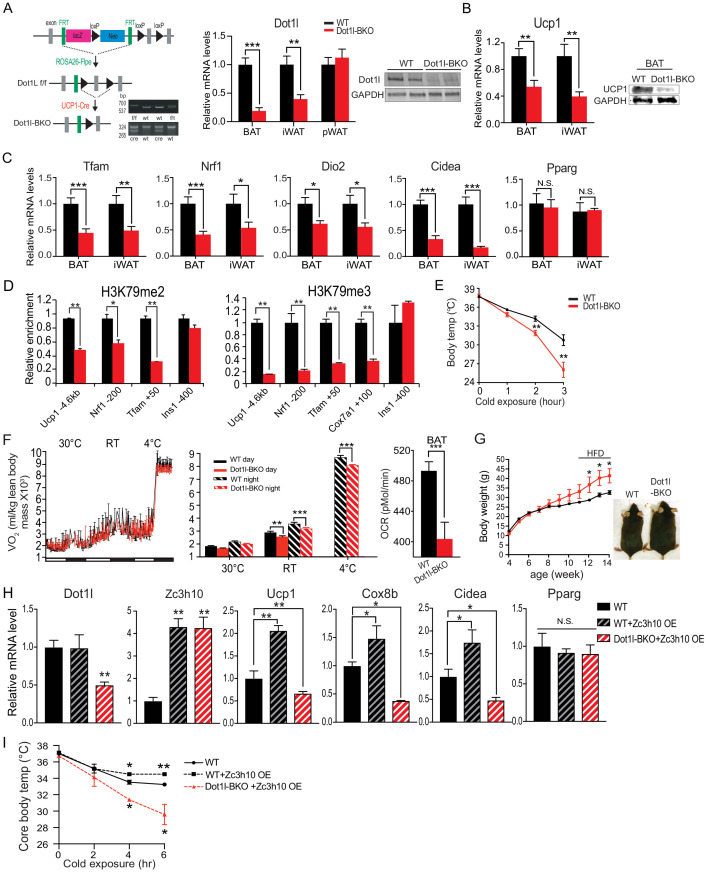
The requirement of Dot1l for cold-induced thermogenesis and the Dot1l-Zc3h10 function in mice.(A) (Left) Schematic diagram of the strategy used to generate BAT-specific Dot1l conditional knockout mice. PCR genotyping of the mice: Top gel, Dot1l allele; bottom gel, Cre. (Middle) RT-qPCR for Dot1l in BAT, iWAT and pWAT from Dot1l f/f (WT) and Dot1l-BKO mice (n = 6 per group). (Right) Immunoblotting for Dot1l in BAT from Dot1l f/f (WT) and Dot1l-BKO mice. (B) RT-qPCR and immunoblotting for Ucp1 in BAT and iWAT from Dot1l f/f (WT) and Dot1l-BKO mice. (C) RT-qPCR for indicated genes in BAT and iWAT from Dot1l f/f (WT) and Dot1l-BKO mice. (D) ChIP-qPCR of H3K79me2 and H3K79me3 at Zc3h10-binding regions of BAT tissue from control (f/f) or Dot1l-BKO mice (n = 5 per group). (E) Rectal temperature measured in 13-week-old mice at 4°C at indicated time points (hours) (n = 6 mice per group). (F) (Left) whole body VO2 assayed in WT and Dot1l-BKO mice, housed at indicated ambient temperatures (n = 6 per group) by indirect calorimetry using CLAMS. (Right) OCR measured in BAT of WT and Dot1l-BKO mice using Seahorse XF24 Analyzer (n = 5 per group). (G) Representative photograph of 14-week-old control and body weight of WT and Dot1l-BKO mice fed HFD from wk 12. (H) RT-qPCR for indicated genes from WT injected with GFP or Zc3h10 adenovirus or Dot1l-BKO mice injected with Zc3h10 adenovirus for overexpression (n = 5 per group). (I) Rectal temperature measured at 4°C at indicated time points (hours) (n = 5 per group). Data are expressed as means ± standard errors of the means (SEM). *p<0.05, **p<0.01, ***p<0.001.